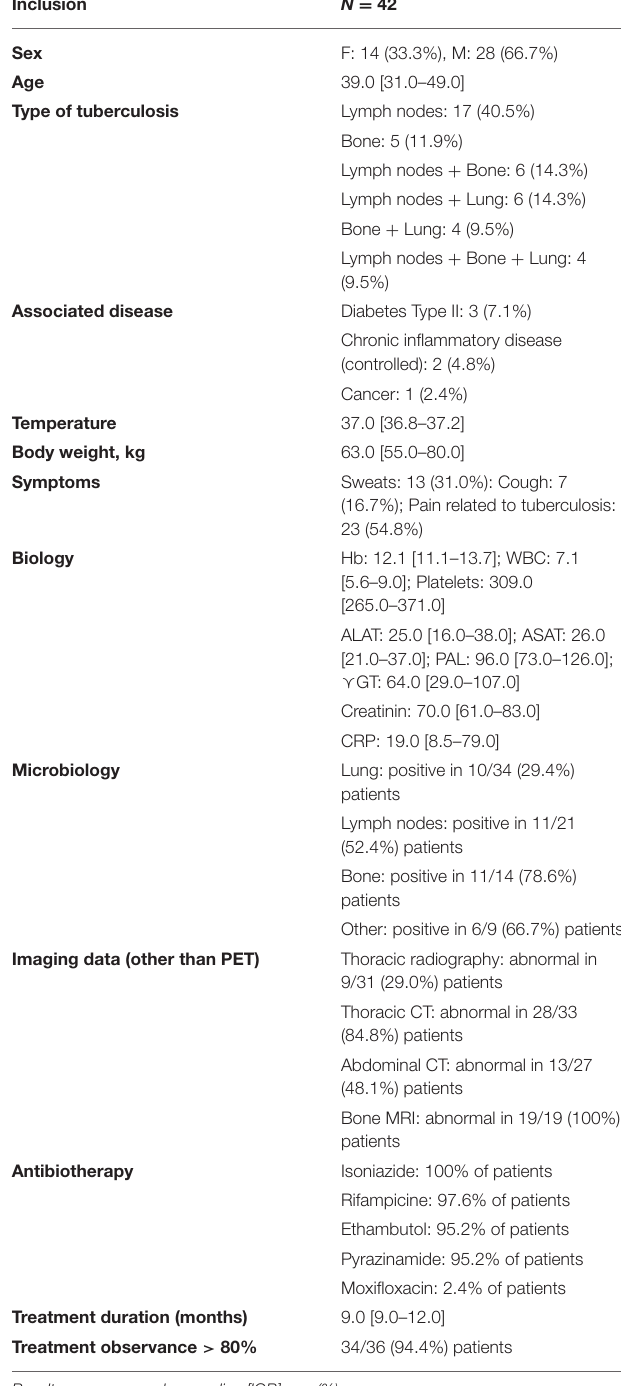
TABLE 1 | Description of the study